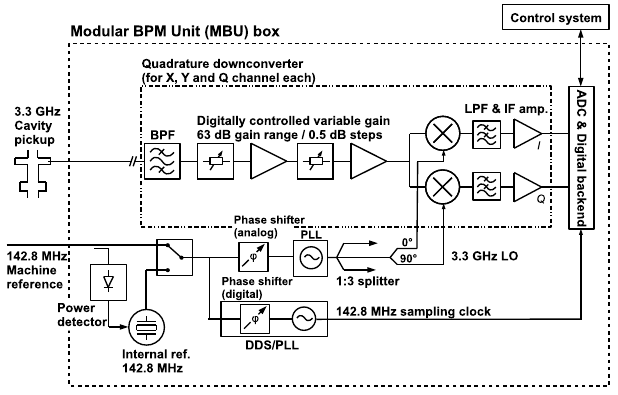
FIG. 42. Simplified schematic of low-Q cavity BPM rf front- end electronics, showing only one of its three input channels (one reference and two position signal channels)